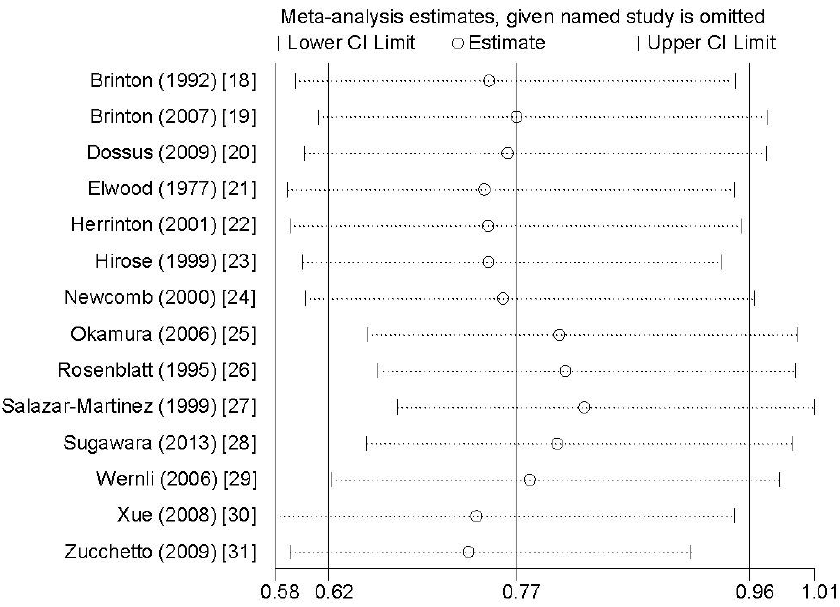
Figure 4. Analysis of influence of individual study on the association between breastfeeding and endometrial cancer risk. Open circles represent the pooled RR and horizontal lines represent the 95% CIs.